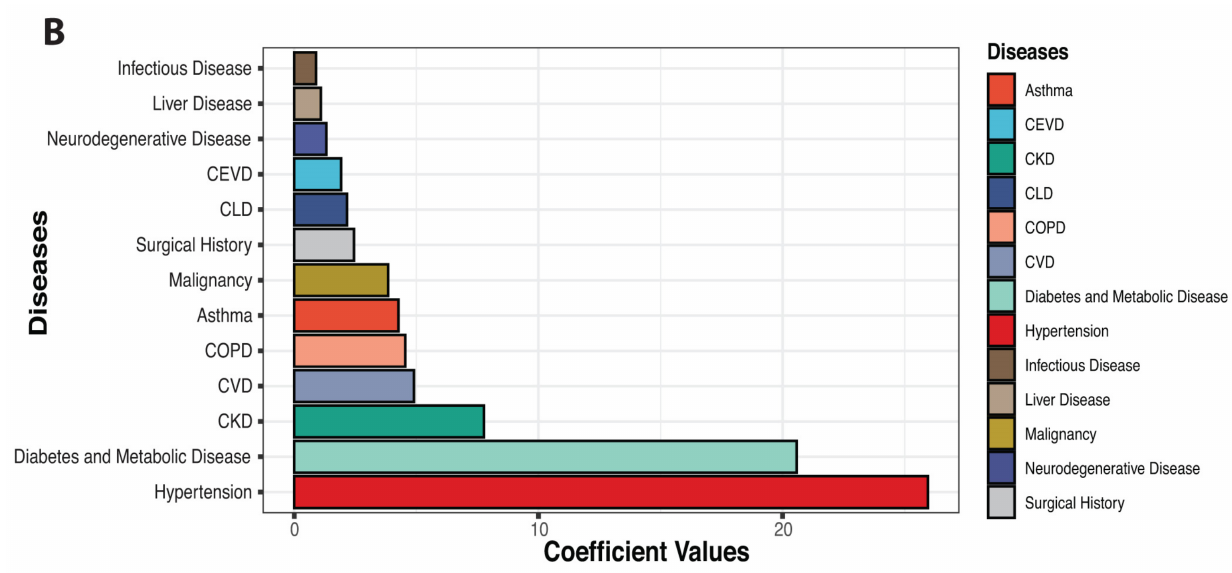
Figure 2. Machine learning models predict the important symptoms and comorbidities that are associated with the severity or death of COVID-19 patients. The high coefficient values of ML model outcomes mean the higher significant association of death. ( A ) represents the significance of symptoms that are linked with death; ( B ) represent the significance of disease comorbidities that are linked with death.